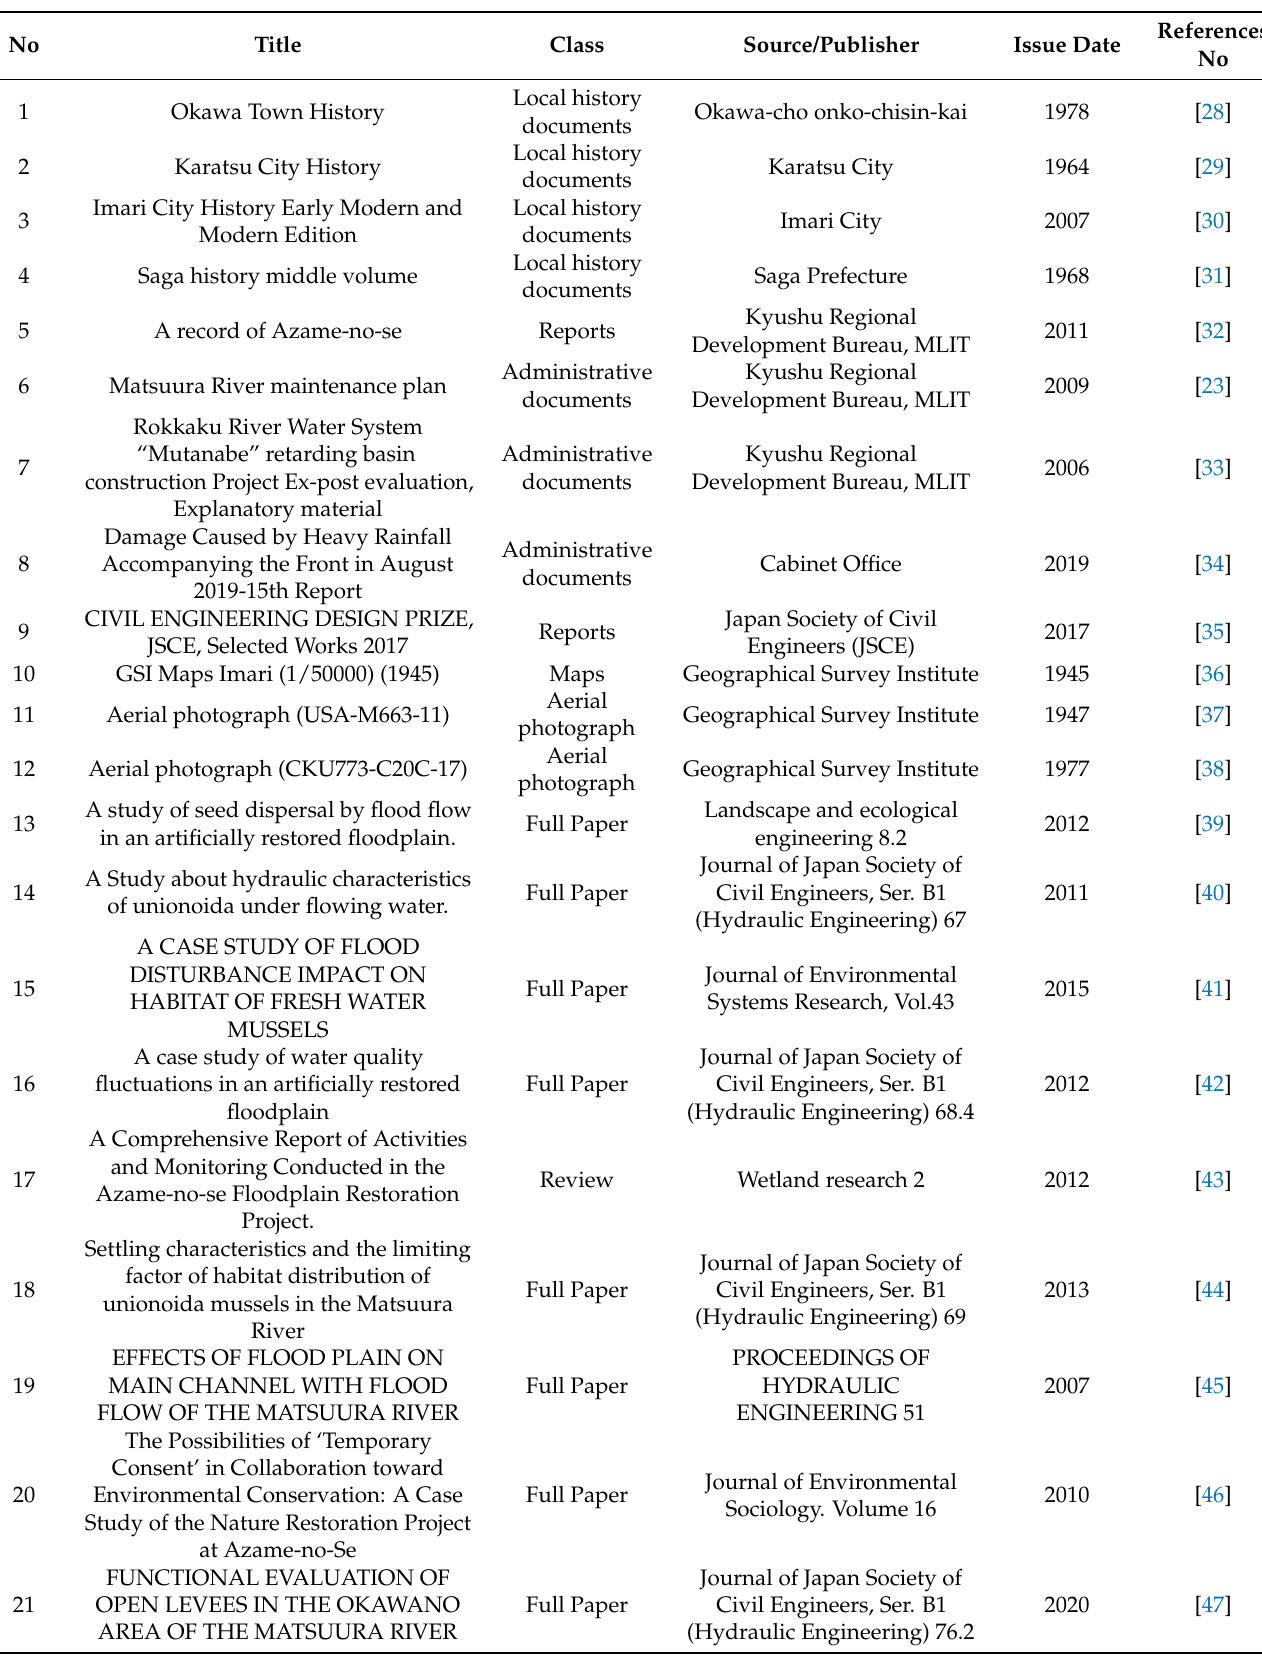
Table 4. A list of the